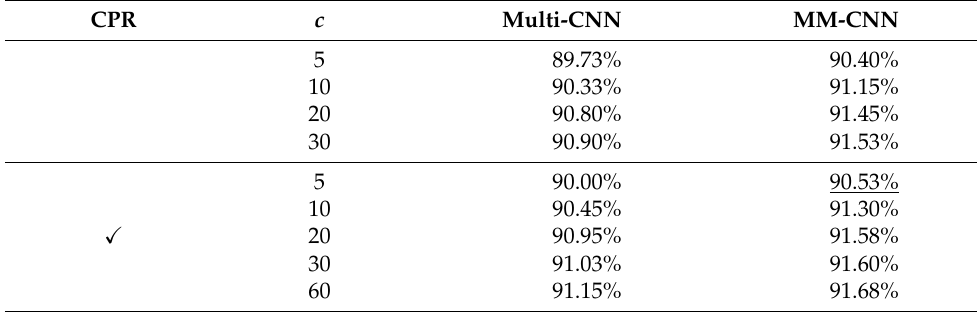
Table 7. Estimation accuracy Multi-CNN and MM-CNN with Mean for CelebA. (cid:88) shows that CPR is used. Best accuracy is shown with underline.